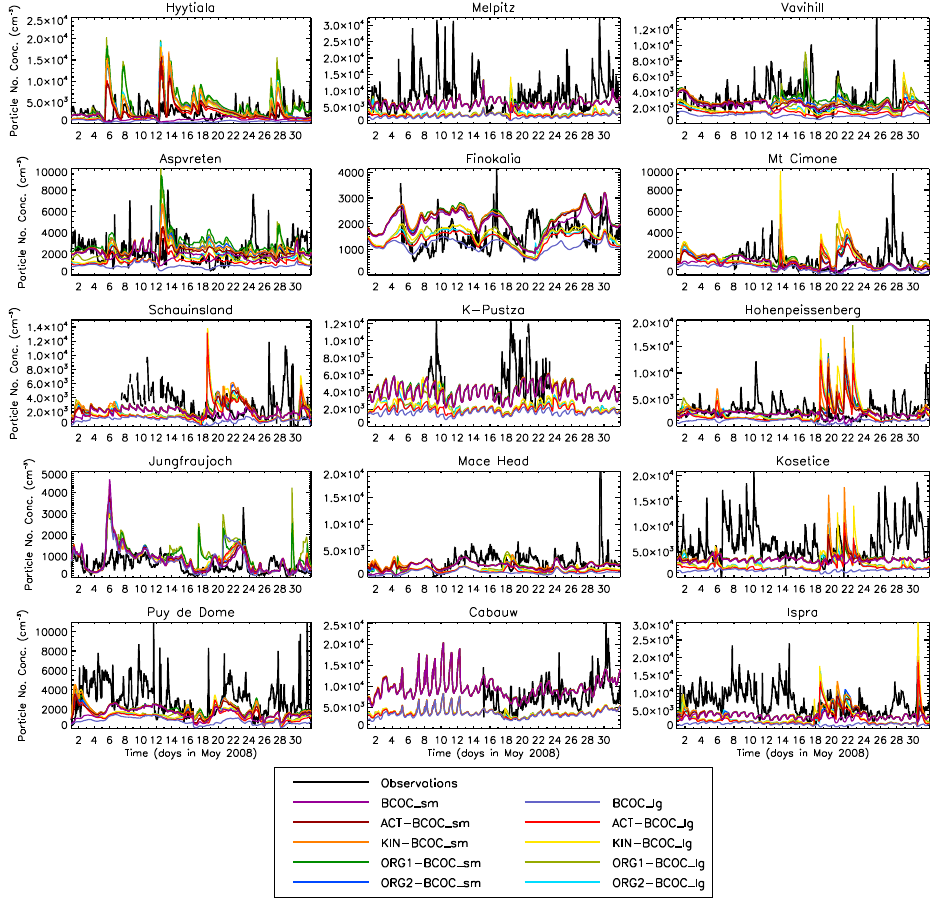
Fig. 11. May 2008 time-series of hourly-mean modelled (colour) and observed (black) particle number concentrations ( D p > 15nm) at each ground site. Model experiments listed in the legend are described in Table